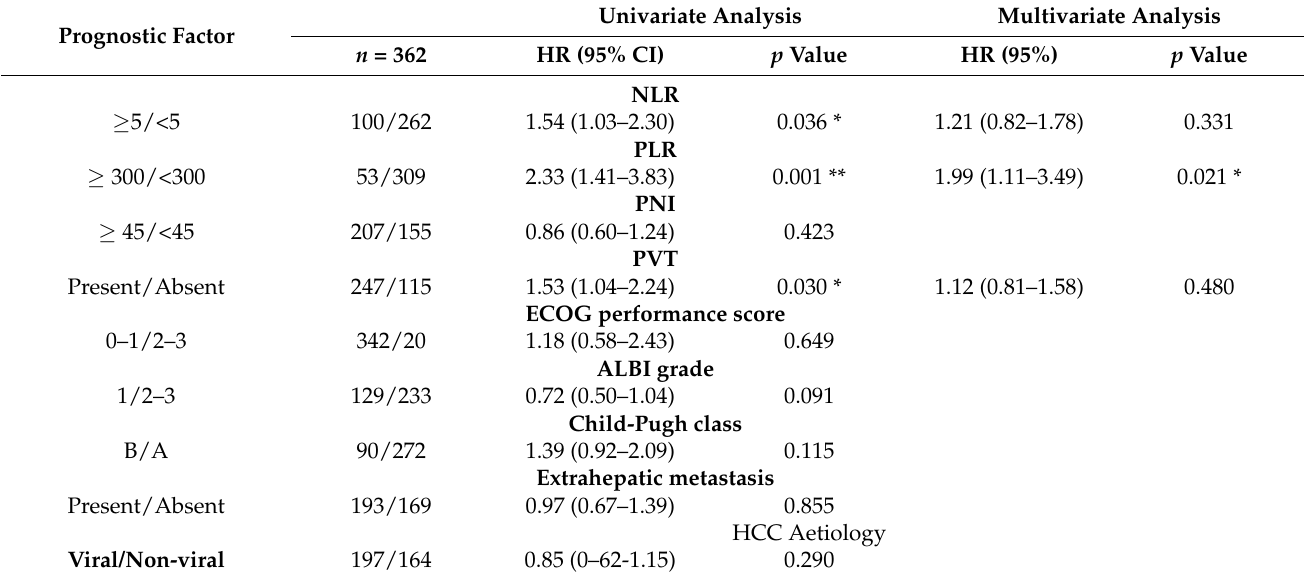
Table 4. Univariate and multivariate Cox regression model for progression free survival. NLR: neu- trophil to lymphocytes ratio; PLR: platelet to lymphocytes ratio; PNI: prognostic nutritional